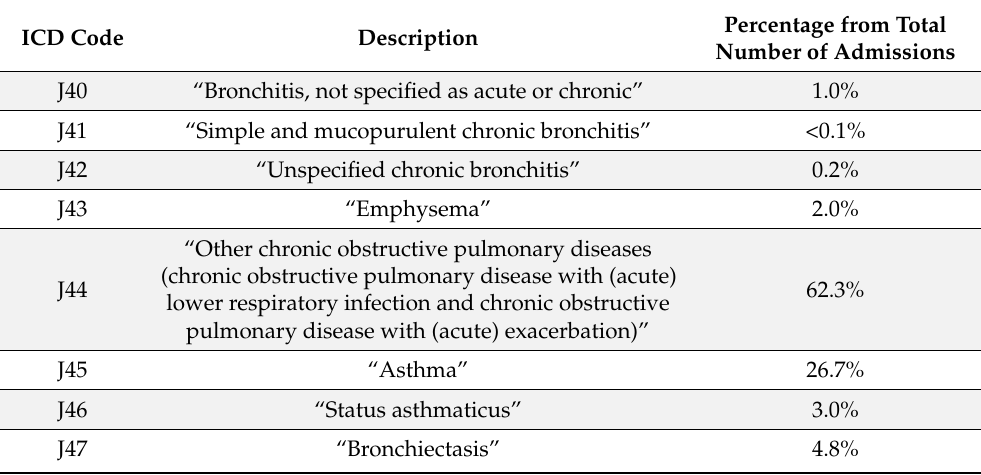
Table 1. Percentage of chronic lower respiratory diseases hospital admission from total number of admissions between 1999 and 2020.